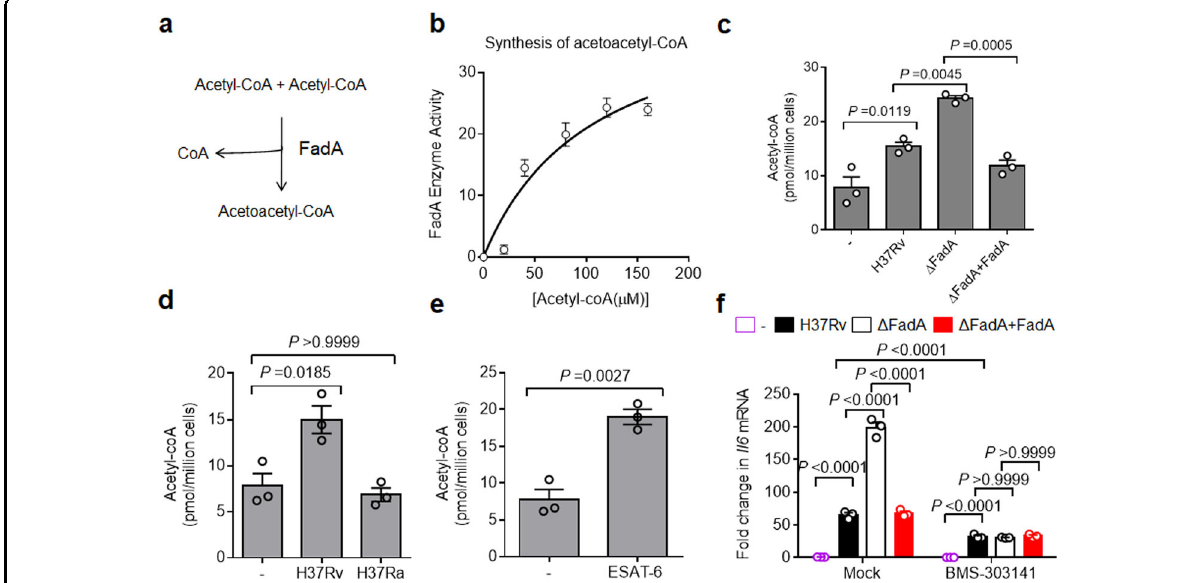
Fig. 5 FadA reduces acetyl-CoA. a Diagram of the acetyl-CoA acetyltransferase activity of FadA. b In vitro two-substrate steady-state kinetic assay of acetyltransferase activity of recombinant FadA protein. c Acetyl-CoA level assay of peritoneal macrophages infected with H37Rv, H37Rv Δ FadA or H37Rv( Δ FadA + FadA) strains for 4 h (MOI = 1) (mean ± SEM). d Acetyl-CoA level assay of peritoneal macrophages infected with H37Rv or H37Ra for 4 h (MOI = 1) (mean ± SEM). e Acetyl-CoA level assay of peritoneal macrophages stimulated with recombinant ESAT-6 protein (5 μ g/mL) for 4 h (mean± SEM). f qPCR analysis of Il6 mRNA from control or ATP-citrate lyase (ACL) inhibitor BMS-303141-pretreated peritoneal macrophages infected with H37Rv, H37Rv Δ FadA, or H37Rv( Δ FadA + FadA) strains for 4 h (MOI = 1) (mean ± SEM). Data in b – f are representative of one experiment with at least three independent biological replicates; each circle represents one technical repeat. One-way ( c , d ) or two-way ( f ) ANOVA with Bonferroni ’ s multiple comparisons test and two-tailed unpaired Student ’ s t- test ( e ) were used for statistical